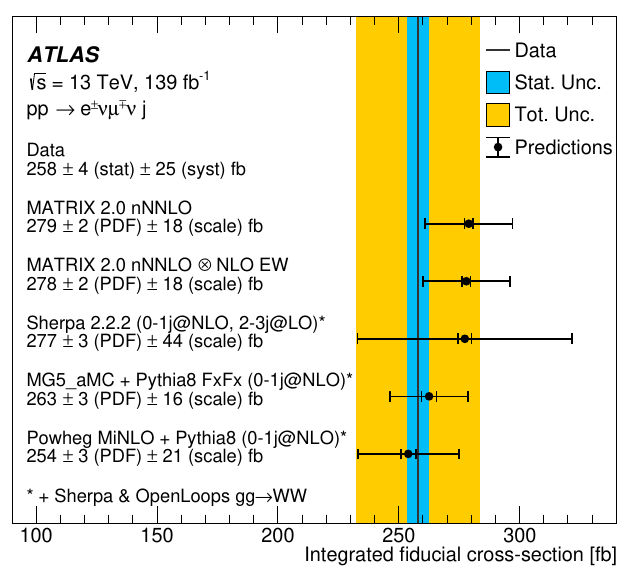
Figure 5 . Comparison of the measured fiducial WW +jets cross-section with various theoretical predictions. Theoretical predictions are indicated as points with inner (outer) error bars denoting PDF (PDF+scale) uncertainties. The central value of the measured cross-section is indicated by a vertical line with the narrow band showing the statistical uncertainty and the wider band the total uncertainty including statistical and systematic uncertainties. The result is compared with a fixed- order parton-level prediction from MATRIX 2.0 that is accurate to NNLO (NLO) for q ¯ q → WW ( gg → WW ) production, and a prediction that additionally accounts for EW corrections to WW + jet production, which have been calculated with Sherpa 2.2.2 + OpenLoops . It is also compared with predictions from Sherpa 2.2.2, MadGraph5 _a MC@NLO + Pythia 8 with FxFx merging, and Powheg MiNLO + Pythia 8, which are all supplemented by a Sherpa 2.2.2 + OpenLoops gg → WW LO+PS